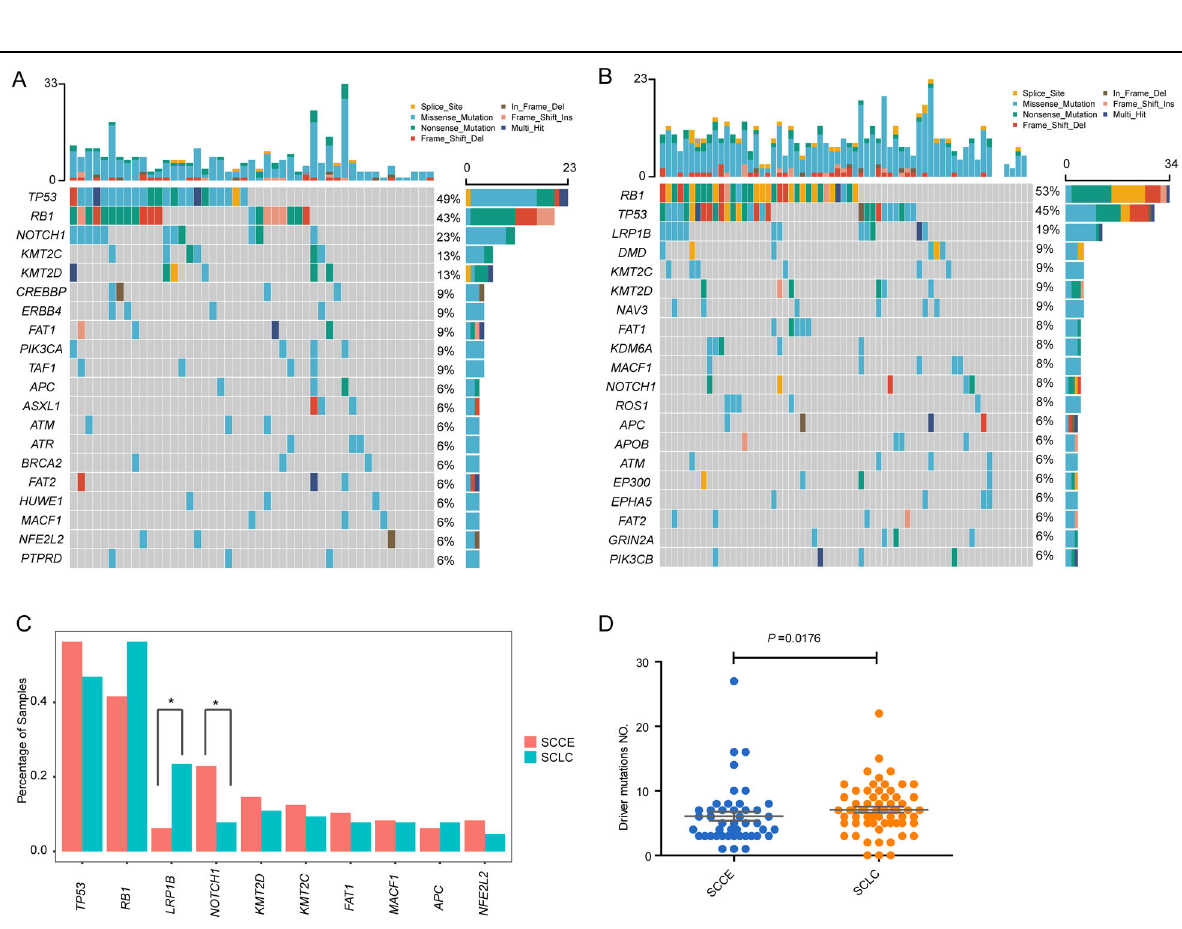
Fig. 2 Driver mutation spectrum of SCCE and SCLC. A Driver mutation pro fi ling of SCCE (Top20 was shown); B Driver mutation pro fi ling of SCLC (Top20 was shown); C Comparison of mutation frequency between SCCE and SCLC; D Driver gene NO. was signi fi cantly lower in SCCE than that in